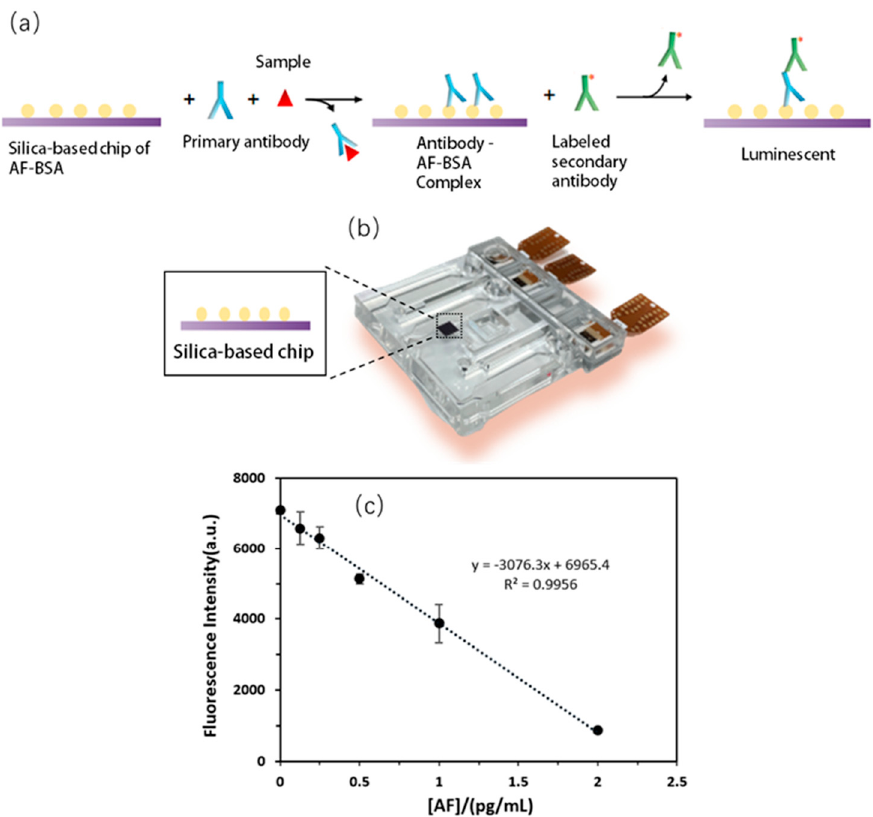
Figure 5. ( a ) Schematic diagram of the principle of competitive immunoassay. ( b ) The modified silicon-based chip in the reaction chamber of microfluidic device. ( c ) The calibration curve of afla- toxin measurement, which was fitted to linear model, where R 2 = 0.9956. Table 1. Measurements of total aflatoxin in samples from microchip and